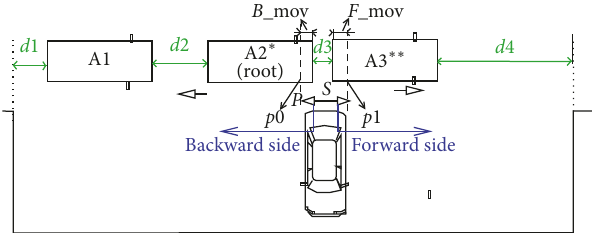
Figure 6: Illustration of key elements in the